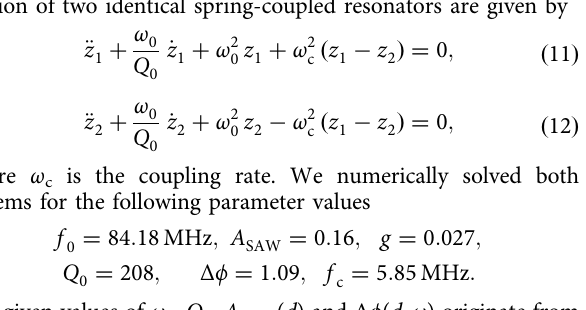
results of the single pillar FEM simulation are given in Supple- mentary Note 2.